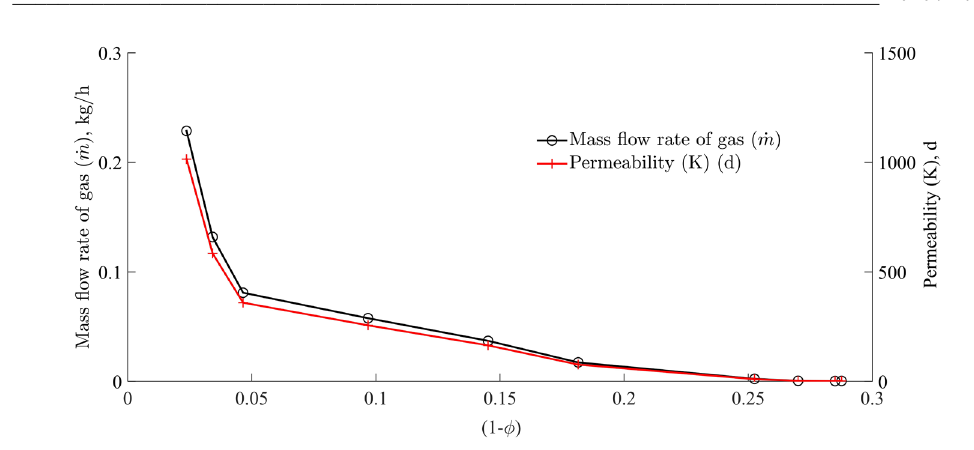
. m ) and permeability ( K ) with respect to voidage (φ) .